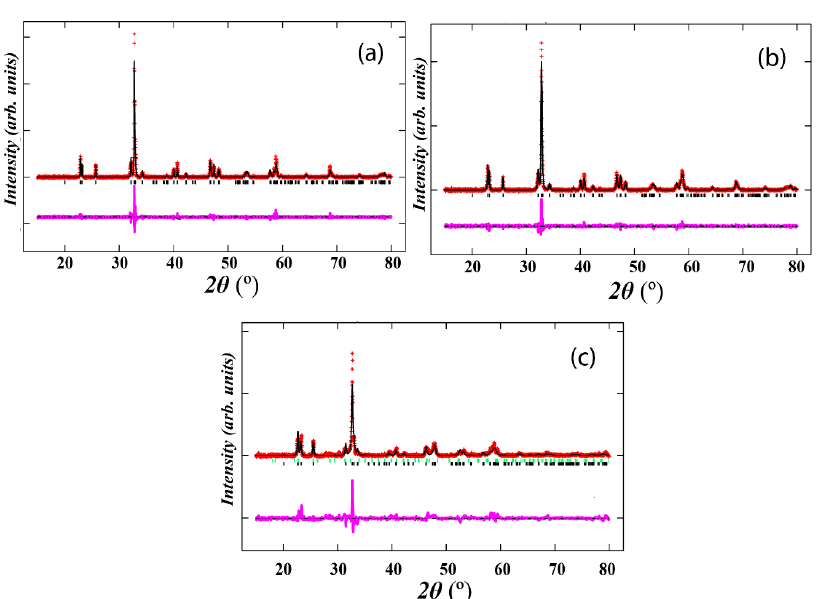
Figure 2. Rietveld refinement for ( a ) NdMnO 3 , ( b ) Nd 0.75 Bi 0.25 MnO 3 and ( c ) Nd 0.5 Bi 0.5 MnO 3 . Black solid lines are observed data, the solid red line is the calculated patterns and the pink line is the difference. Tick marks indicate the allowed Bragg reflections. Bi 2 O 3 impurity phase was detected for Nd 0.5 Bi 0.5 MnO 3 and indicated by green tick